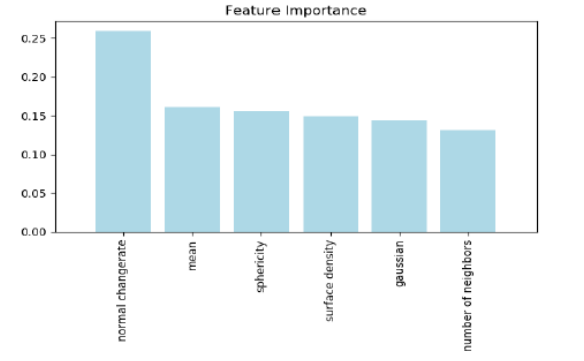
Figure 5. Feature importance statistics after feature